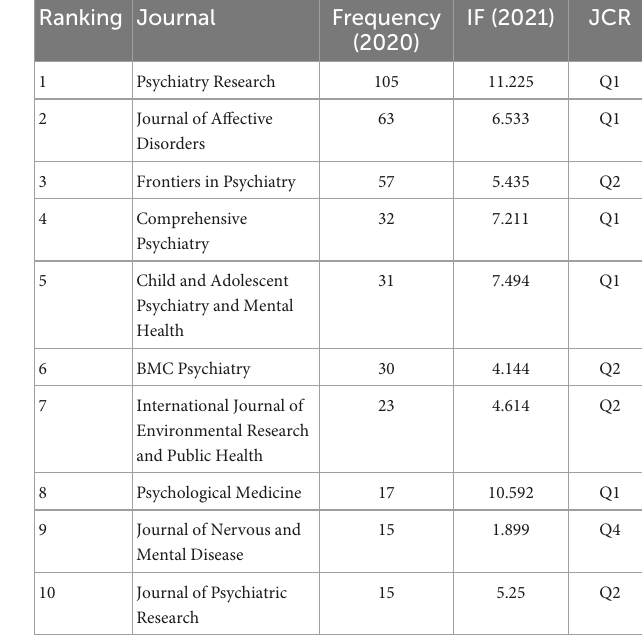
TABLE 4 The top 10 journals with the highest frequency of non-suicidal self-injury